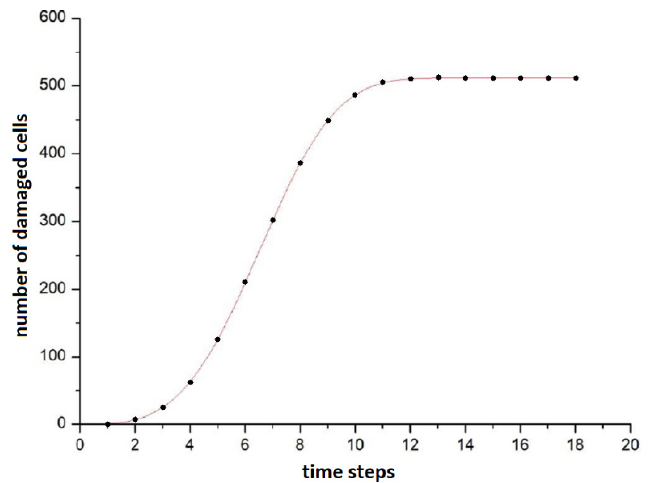
Figure 2. The number of cells with bystander damages in the function of time (black dots). The Avrami curve with the Equation 512 − 511.55 ∙ exp ( − (0.13 ∙ 𝑥 ) 3,4 ) [26] was fitted.